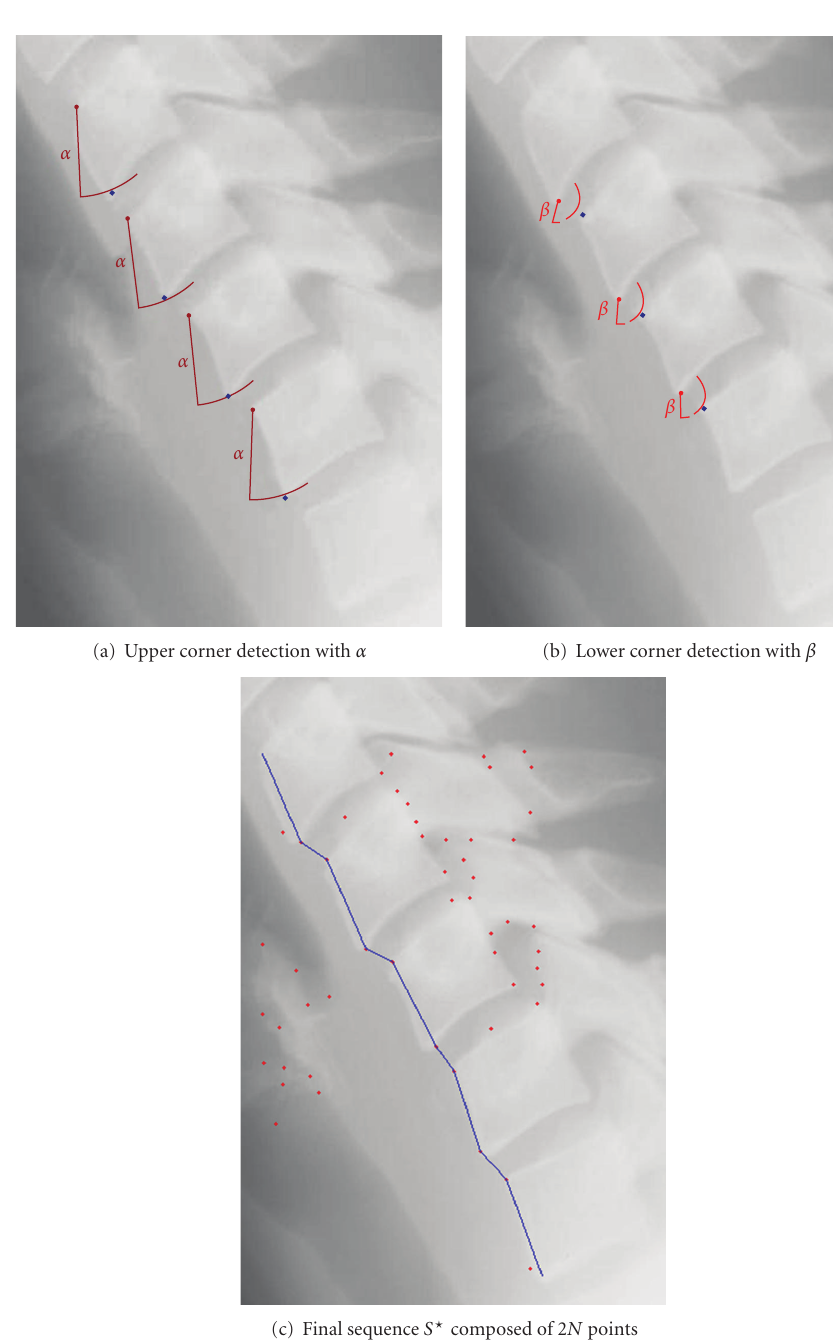
Figure 9: Illustration of the construction of the sequence S (cid:2)